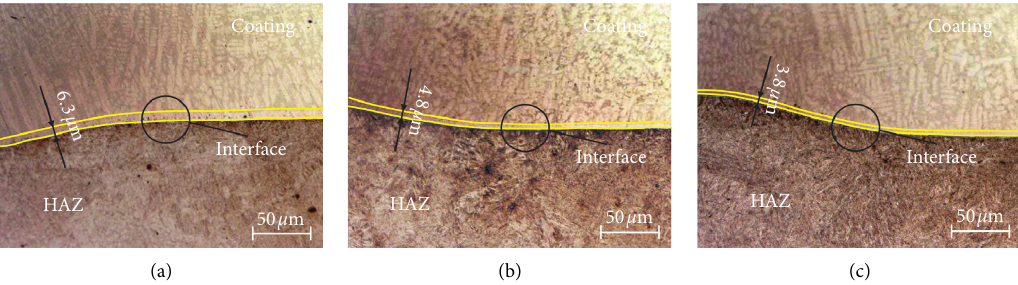
Figure 4: Optical microstructure of the interface between the substrate and the Ni45 coatings: (a) C1, (b) C2, and (c) C3.